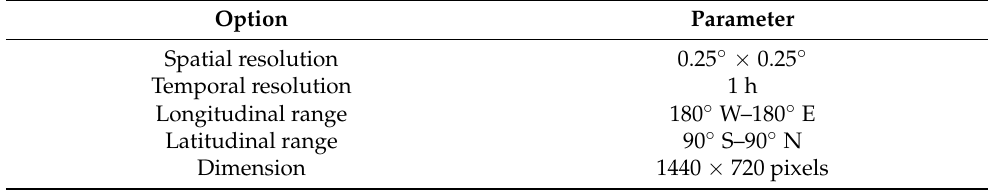
Table 1. Summary of the wind data.